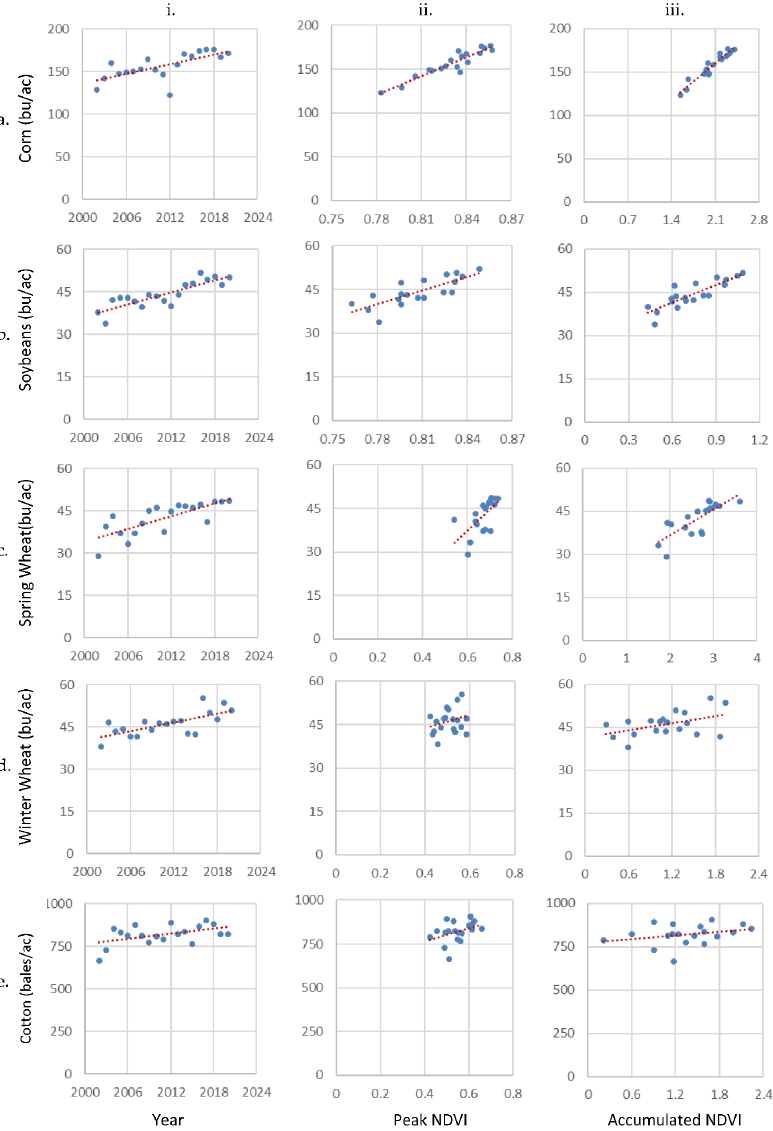
Figure 4. Relationships of USA-level crop yield versus year, peak NDVI, and accumulated NDVI (crop by row: a . corn, b . soybeans, c . spring wheat, d . winter wheat, e . cotton; model by column: i . year, ii . peak NDVI, iii . accumulated NDVI). The LSR line is in dotted red with the corresponding R 2 , SE, and CV values shown in Table 1.